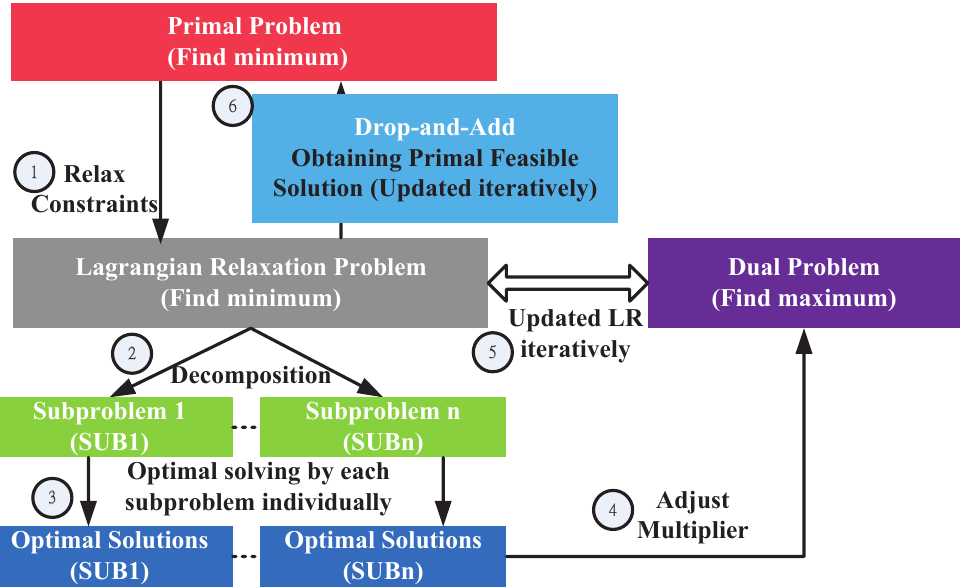
Figure 3. Lagrangian relaxation-based solution process